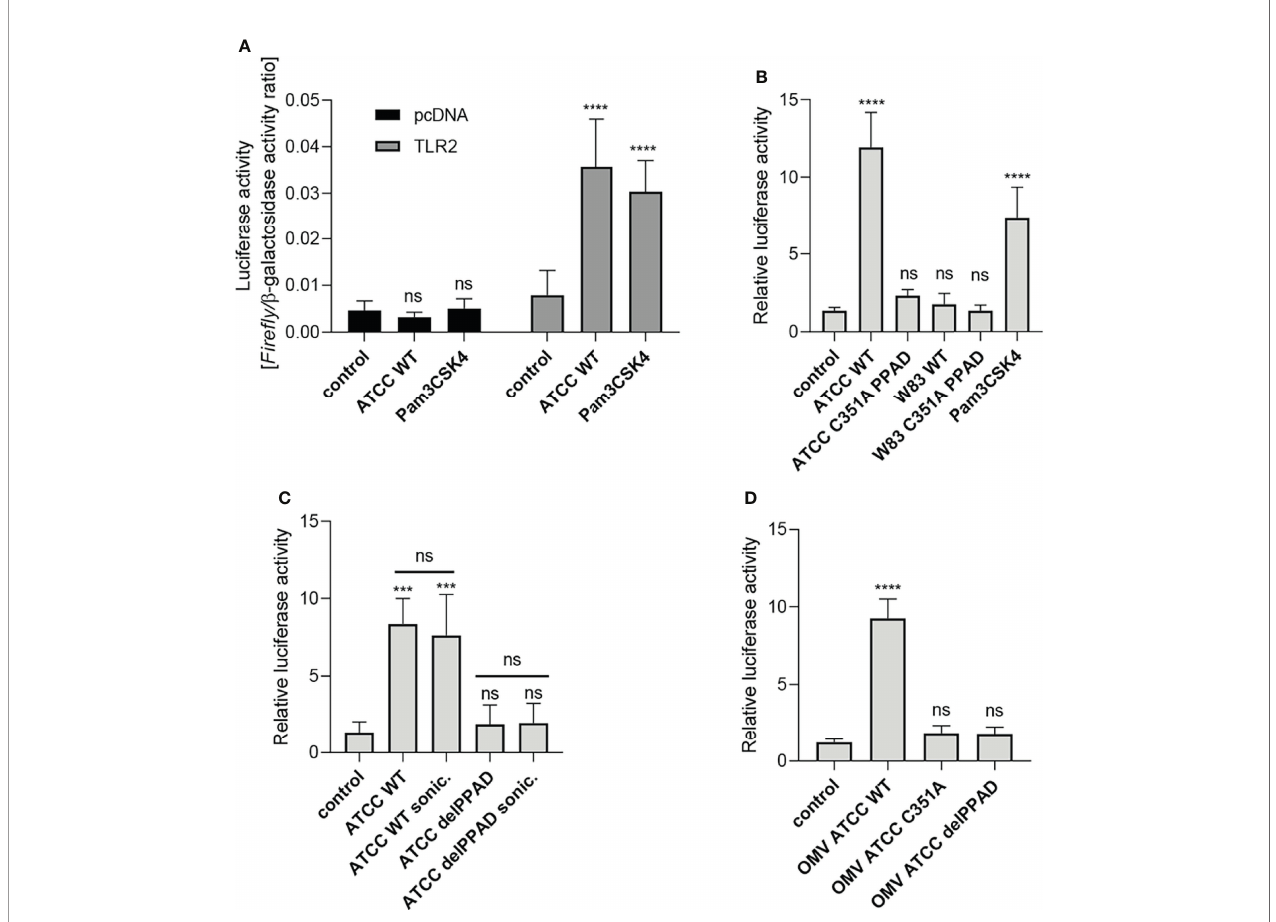
FIGURE 1 | Activation of TLR2 is dependent on PPAD expression and activity. U251 MG cells overexpressing the TLR2 receptor were infected (MOI=100) or treated for 4 h with (A) ATCC 33277 strain or Pam3CSK4 (1 m g/ml), n=5-7; (B) various P. gingivalis strains and ATCC-derived isogenic mutants of catalytically inactive PPAD (C351A PPAD), n=3-5; (C) ATCC 33277 wild-type and PPAD mutant strains and sonicates (cells were lysed by sonication (sonic.)), n=4; or (D) outer membrane vesicles (OMVs) isolated from ATCC 33277 strain and its isogenic PPAD mutants (2 µg/ml), n=4. Results in (A) are presented as a ratio of Fire fl y luciferase activity to b -galactosidase activity. Results in (B – D) are presented as a ratio of Fire fl y luciferase activity to b -galactosidase activity. Data are normalized to those from cells stimulated/infected with the same factor and transfected with an empty vector. Mean + SD; ****p < 0.0001; ***p < 0.001; ns, no statistical signi fi cance; 1-way ANOVA both followed by Tukey ’ s multiple comparisons test. ATCC WT- ATCC